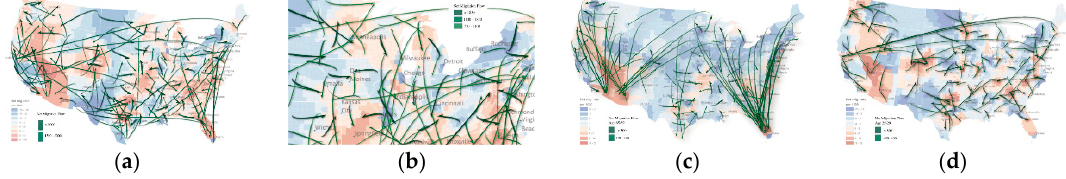
Figure 49. Flow-map visualizations at an early stage: ( a ) migration flow map of the United States Census [128]; ( b ) migration map of outflows from Colorado by using edge routing [129]; and ( c ) domestic flights in the United States by using the edge-bundling technique [130].